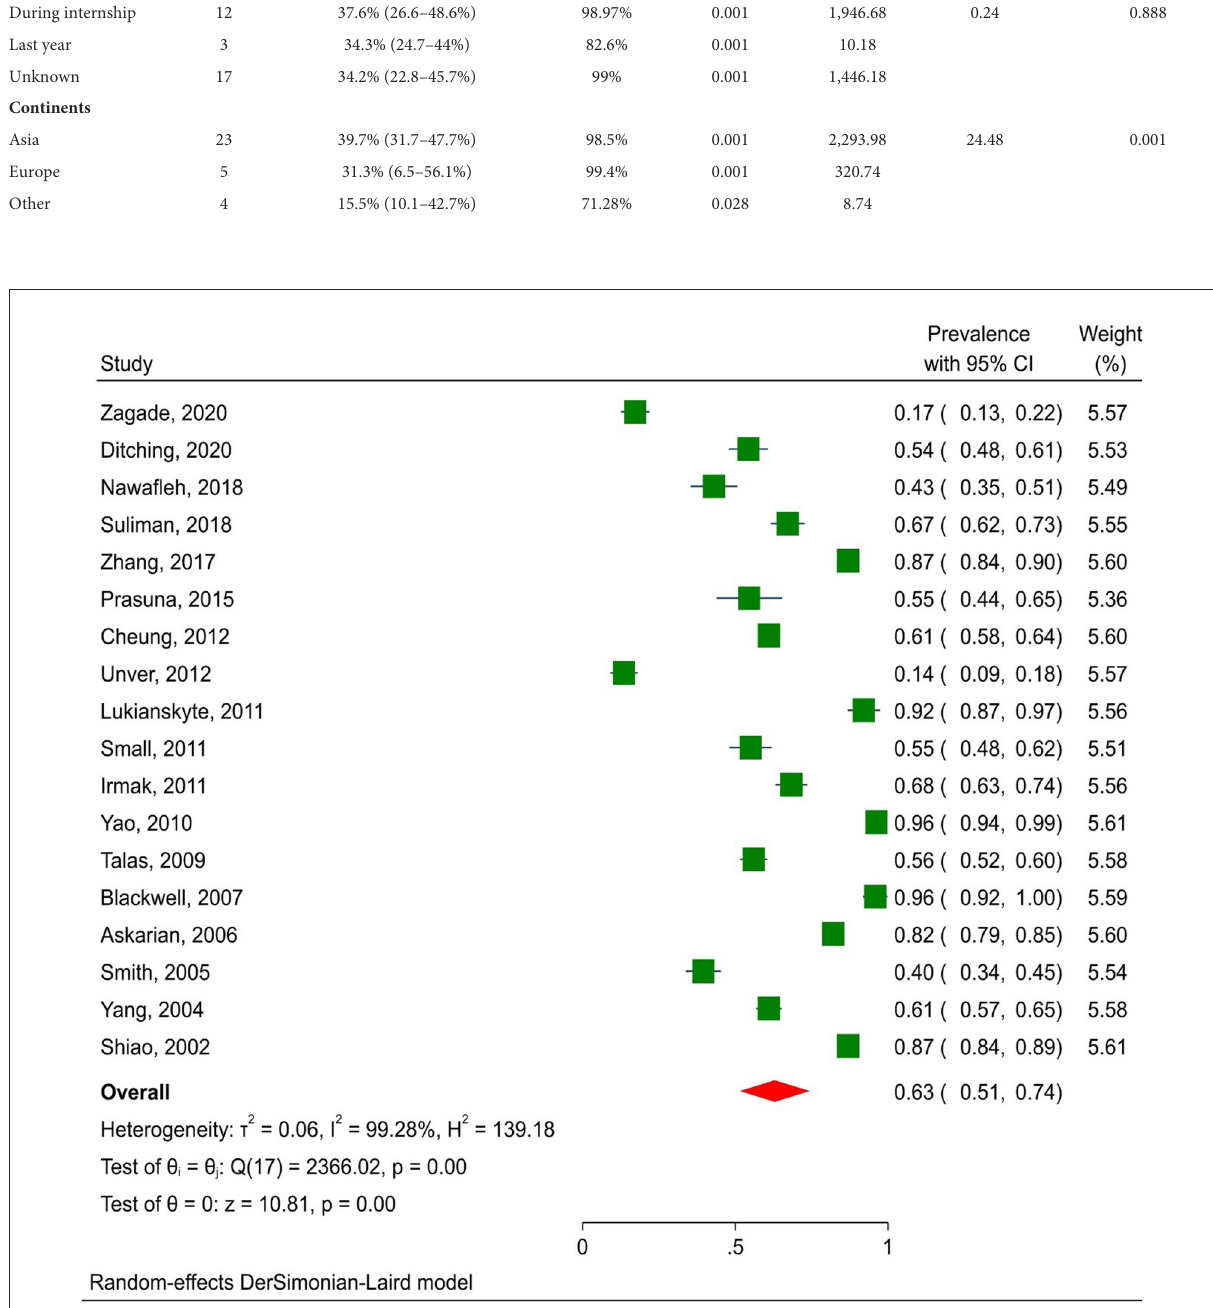
FIGURE3 The frequency of NSI non-reporting among nursing